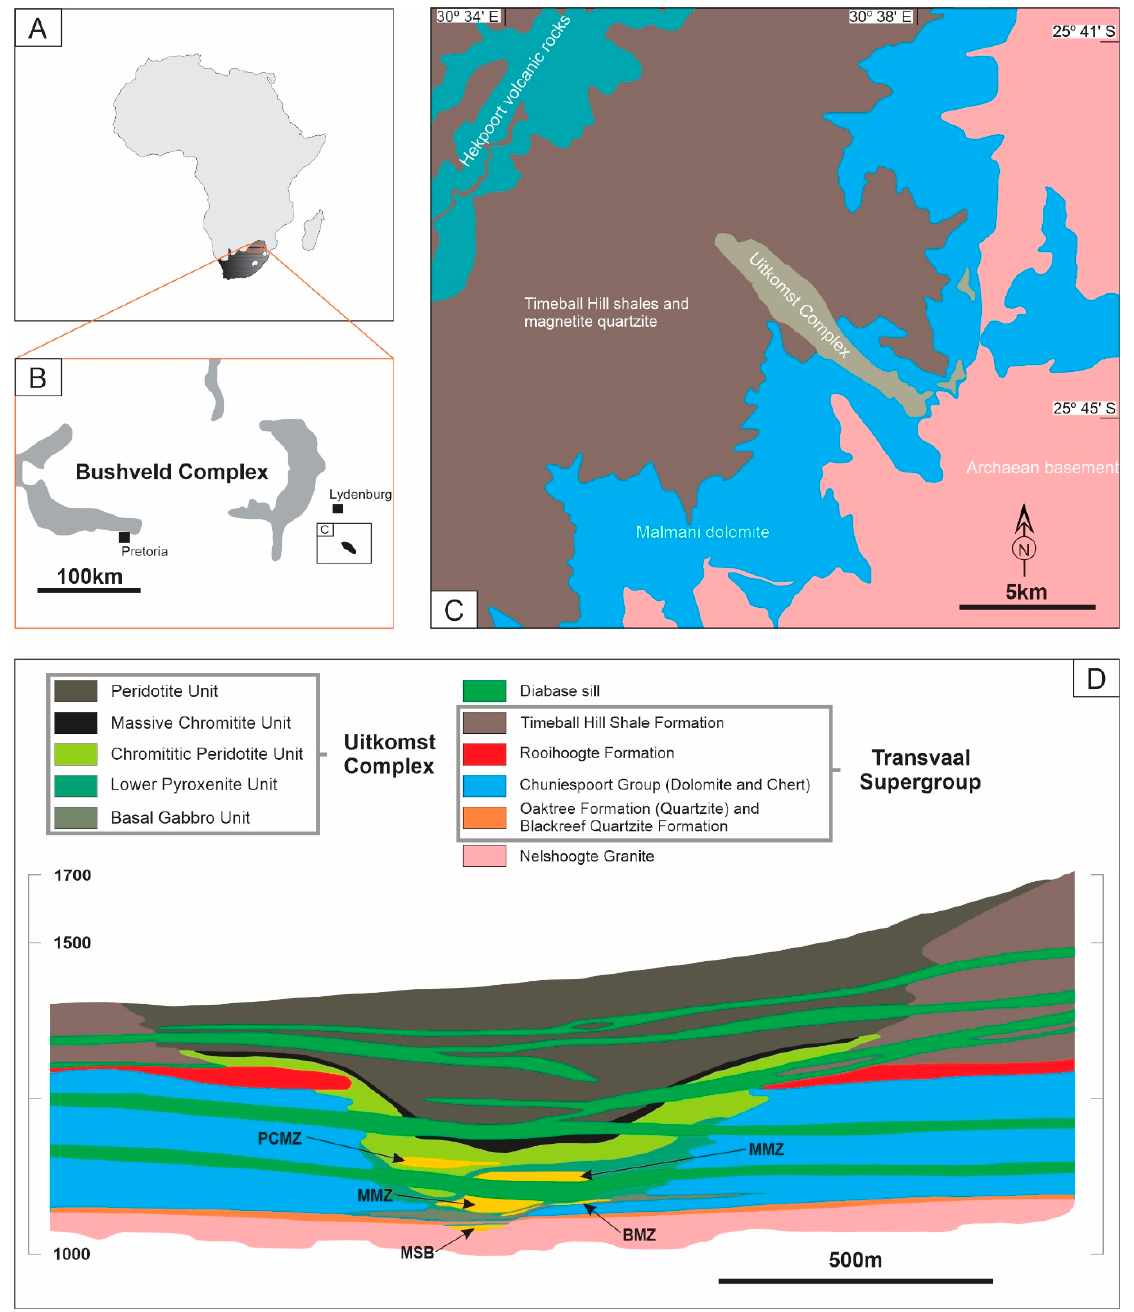
Figure 1. Locality and simplified geological map including a cross section of the Uitkomst Complex at Nkomati Nickel mine. ( A ) = Regional location. ( B ) = Enlarged region as shown in A. ( C ) = Simplified geological map showing the Uitkomst Complex. ( D ) = Cross section of the Uitkomst Complex at the Nkomati Nickel mine including the ore bodies. Modified after [34,36] and [37].